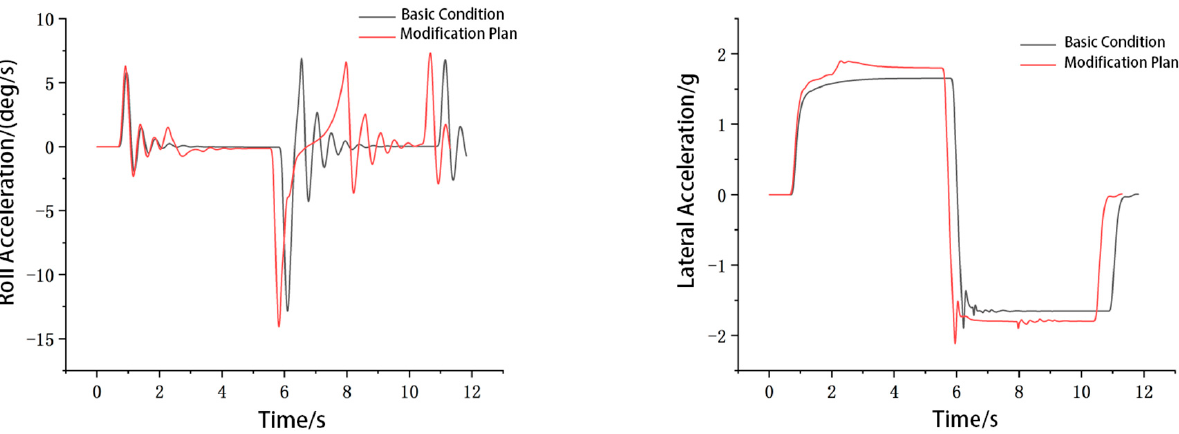
Figure 28. Comparison curves of roll angle velocity and lateral acceleration of figure-eight surround simulation with different aerodynamic parameters.